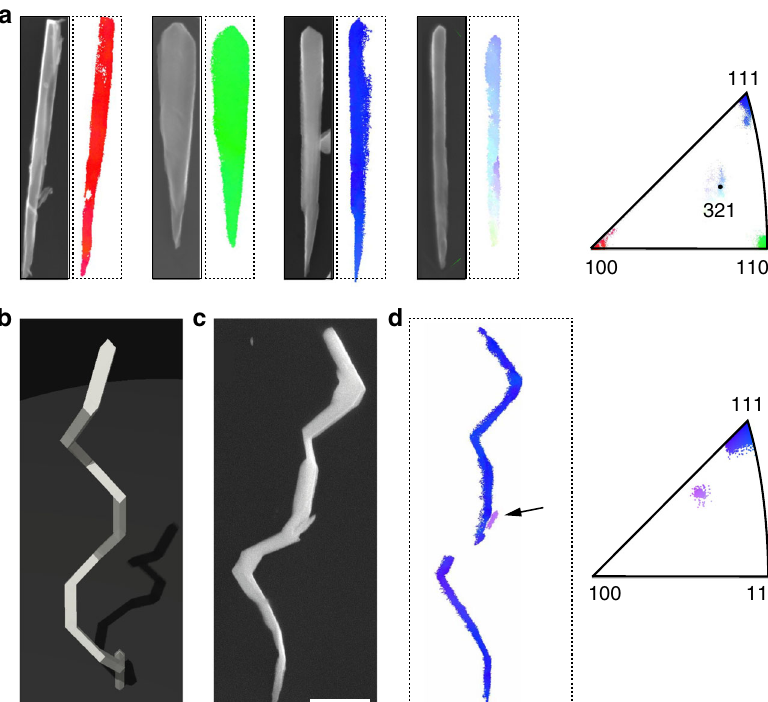
Fig. 4 Demonstration of three-dimensional growth. a Scanning electron micrographs and corresponding transmission Kikuchi diffraction (TKD) patterns for 〈 100 〉 , 〈 110 〉 , 〈 111 〉 , and 〈 321 〉 nanowires that served as the building blocks for 3D growth. Nanowires are 3 µ m in length. b Schematic, c SEM micrograph, and d TKD image of a three-dimensional FeCo spiral with 12 segments. Orientation color-coding is with respect to the helical axis. The small segment of missing TKD data is caused by self-shadowing of the spiral with respect to the detector. A small misoriented crystallite is also visible (arrow). Scale bar in c is 1 µ